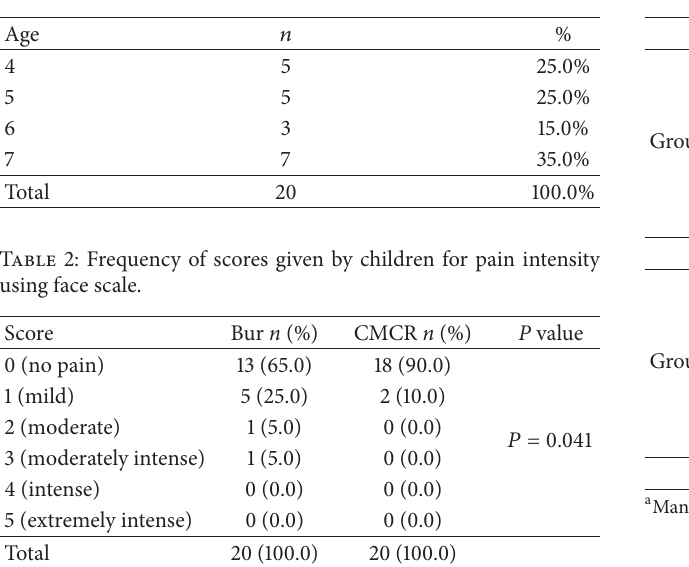
Table 1: Distribution of children in sample according to age.